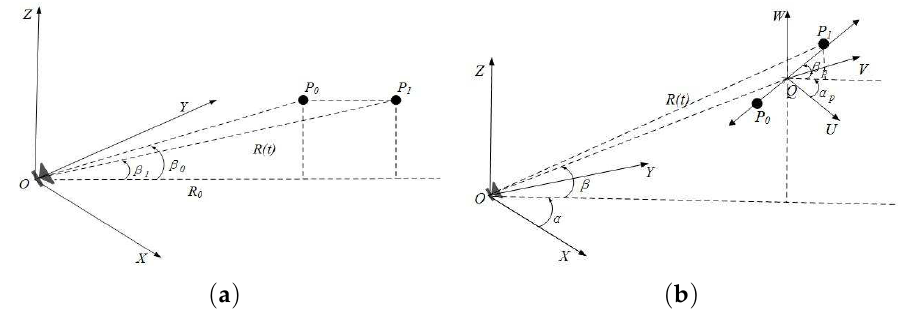
Figure 1. ( a ) spatial phase plane behavior of non-uniform motion object; ( b ) spatial phase plane behavior of the arm swing